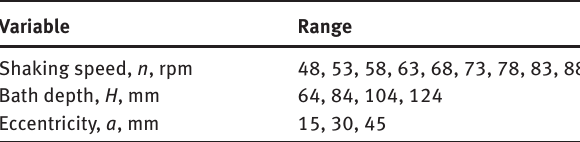
Table 1: Operating variables and their ranges of model experiments Variable